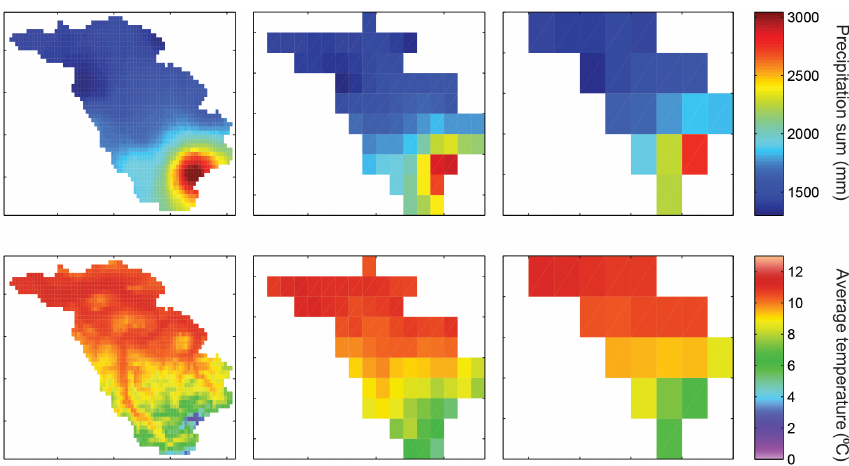
Figure 3. Upper panels: the precipitation sum in the Thur catchment over the full model period (1 August 2002–31 August 2003) shown for different resolutions (f.l.t.r.: 1km × 1km, 5km × 5km, 10km × 10km). Lower panels: the average temperature over this period for the same spatial